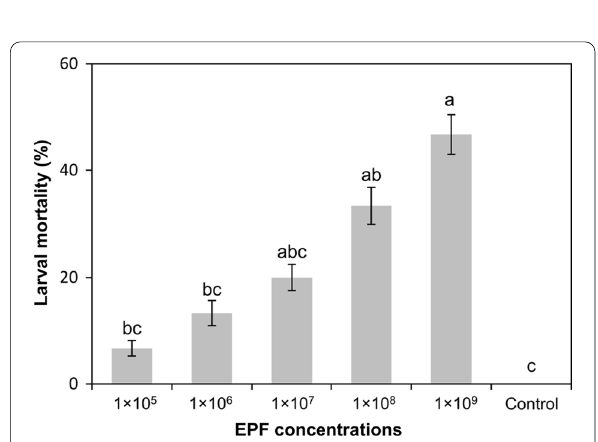
Fig. 3 Effect of various conidial concentration of Metarhizium anisopliae on larval mortality (%